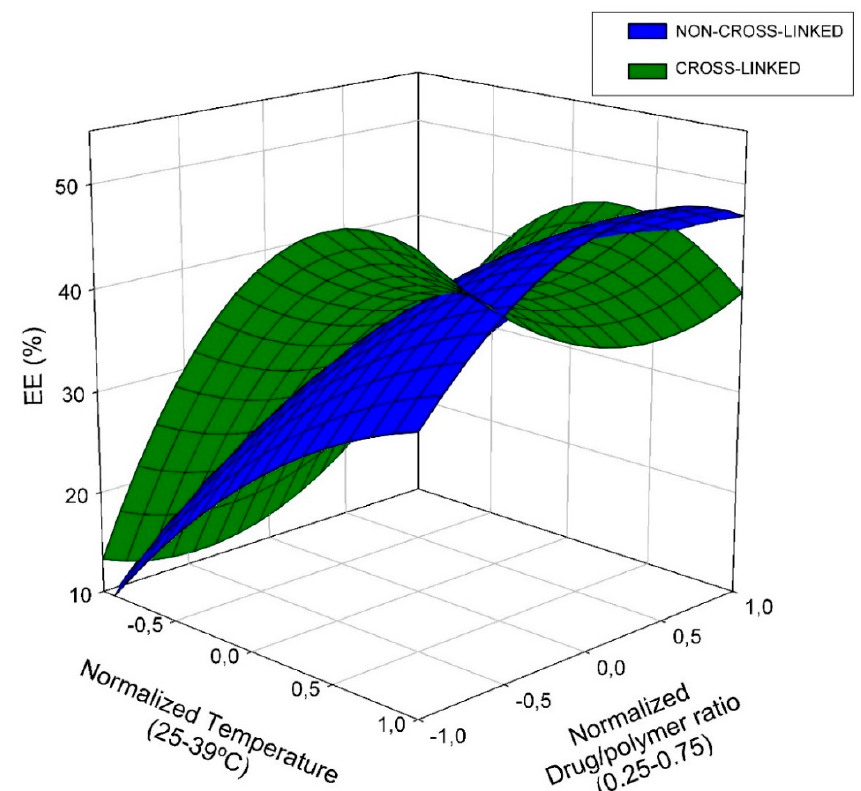
Figure 3. Response surface for RES encapsulation efficiency percentage on both, non- and cross-linked NPs.